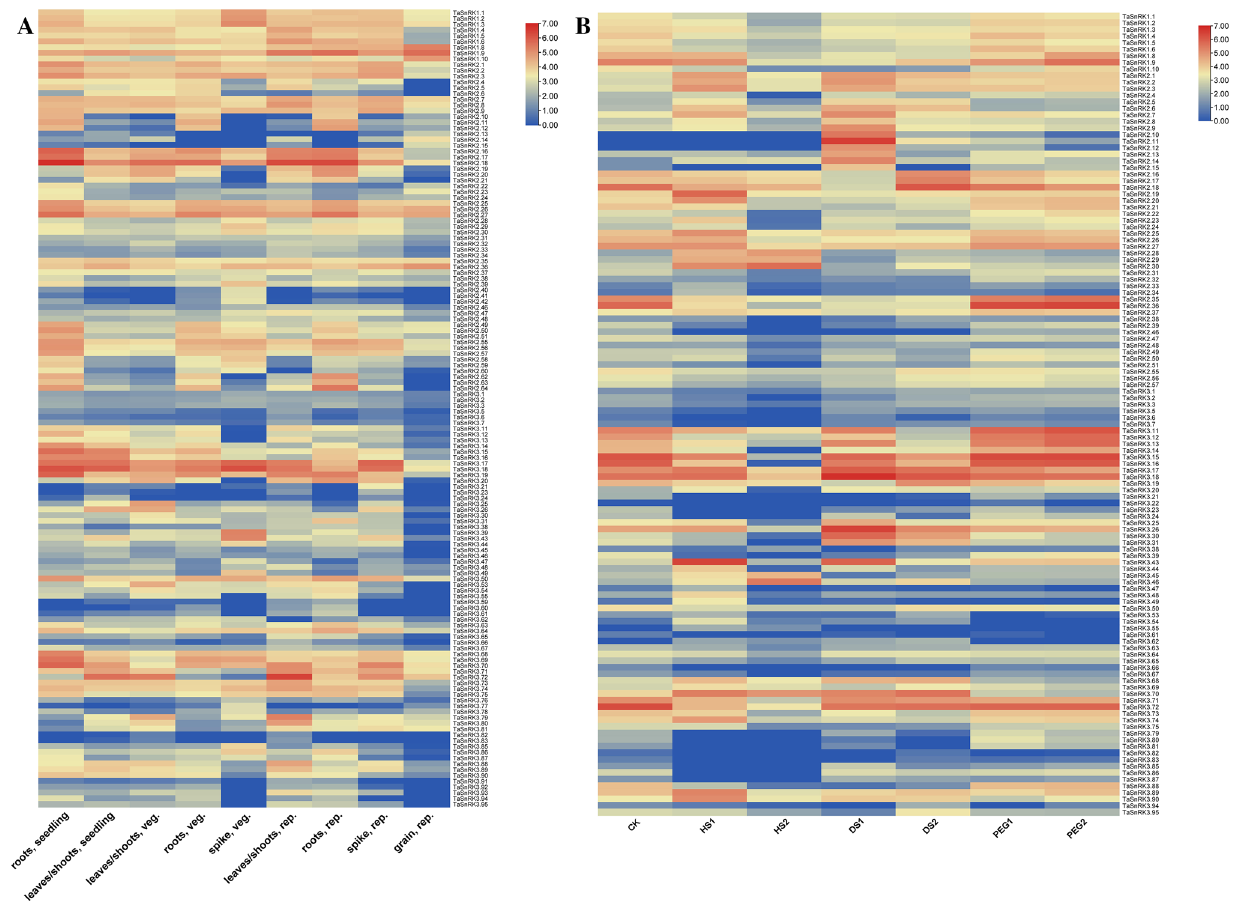
Figure 7. Heatmap of TaSnRK genes ( A ) tissue specific expression in leaf, root, shoot and spike at seedling, vegetative and reproductive stages ( B ) abiotic stress specific expression under drought, heat and osmotic stress at seedling stage. The color scale represents log 2 expression values. Ck-control; HS1-heat stress at 1hr; HS2-heat stress at 6hr; DS1- drought stress at 1hr; DS2- drought stress at 6hr; PEG1- osmotic stress at 2hr; PGE2- osmotic stress at 12